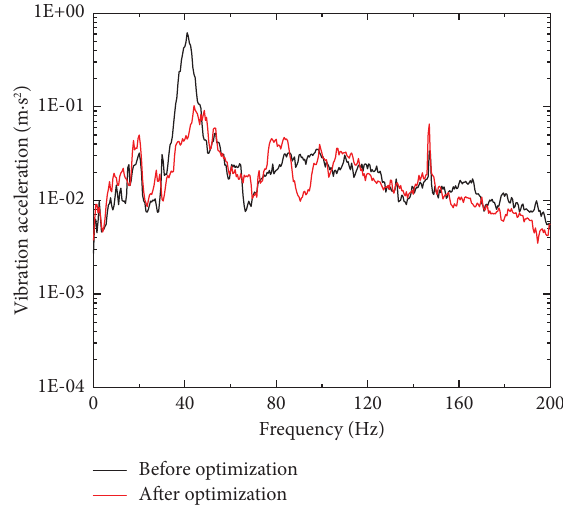
Figure 8: Comparison of the vibration spectrum of the inner side of the car body end wall before and after optimization.